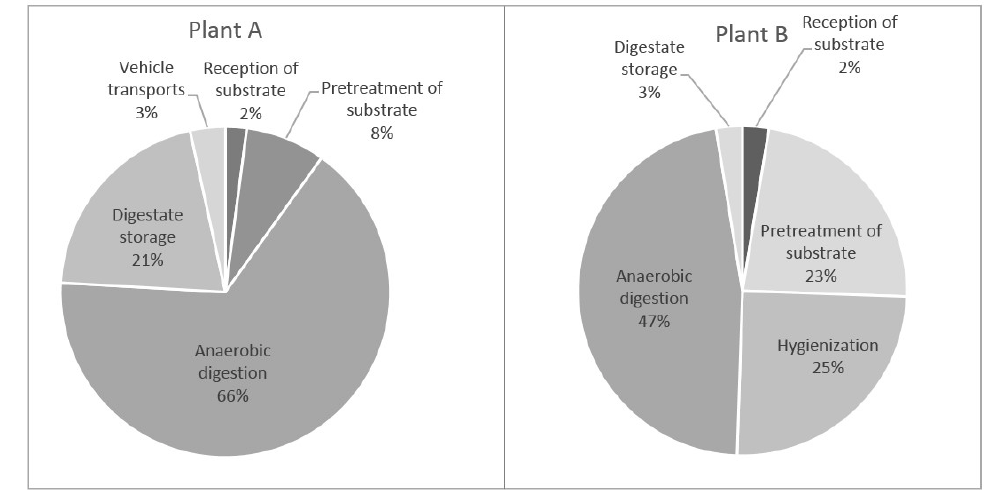
Figure 13. The total energy use at system Level 1, allocated to sub-processes for plant A and B, respectively. For plant A, the only energy carrier used during the measurement period was electricity.